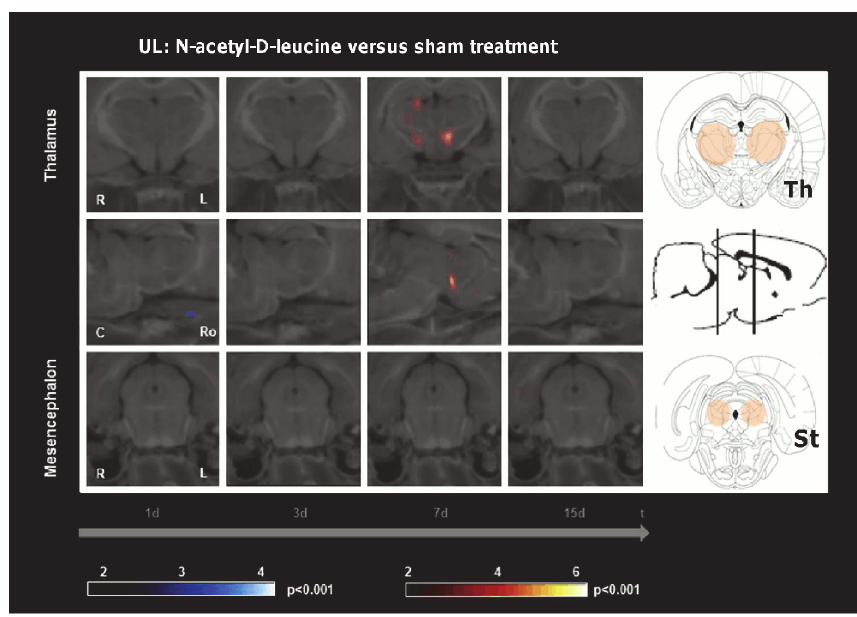
Fig 5. Regional cerebral glucose metabolism after N-acetyl-D-leucine as compared to sham treatment following unilateral labyrinthectomy. The images depict group-wise comparisons of the regional cerebral glucose metabolism (rCGM) on days 1, 3, 7 and 15 after unilateral labyrinthectomy (UL). The N-acetyl-D- leucine group (24 mg i.v. per rat) showed an increase of rCGM in the centromedian thalamus and hypothalamic area compared to the sham treatment group on day 7. There were no further differences of rCGM in any other cerebral region at any other time point. R right, L left, C caudal, Ro rostral, St subthalamic region, Th thalamus; p-value <